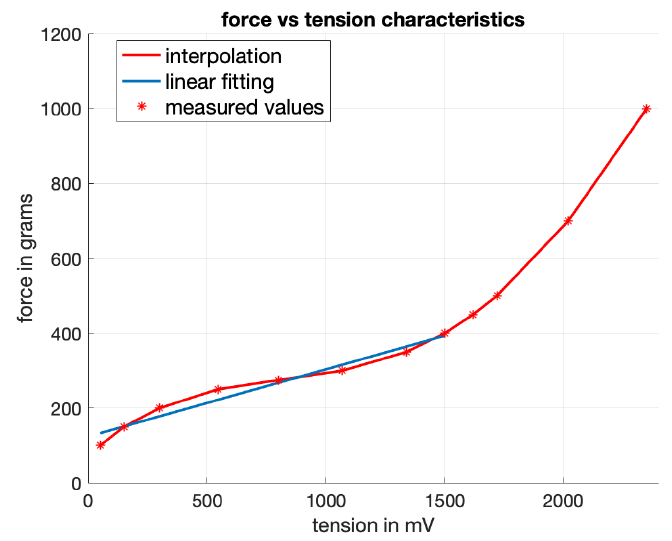
Figure 5. Static force in grams as a function of the tension output in mV of the sensors. The relation is almost linear between 50 and 1500 mV.